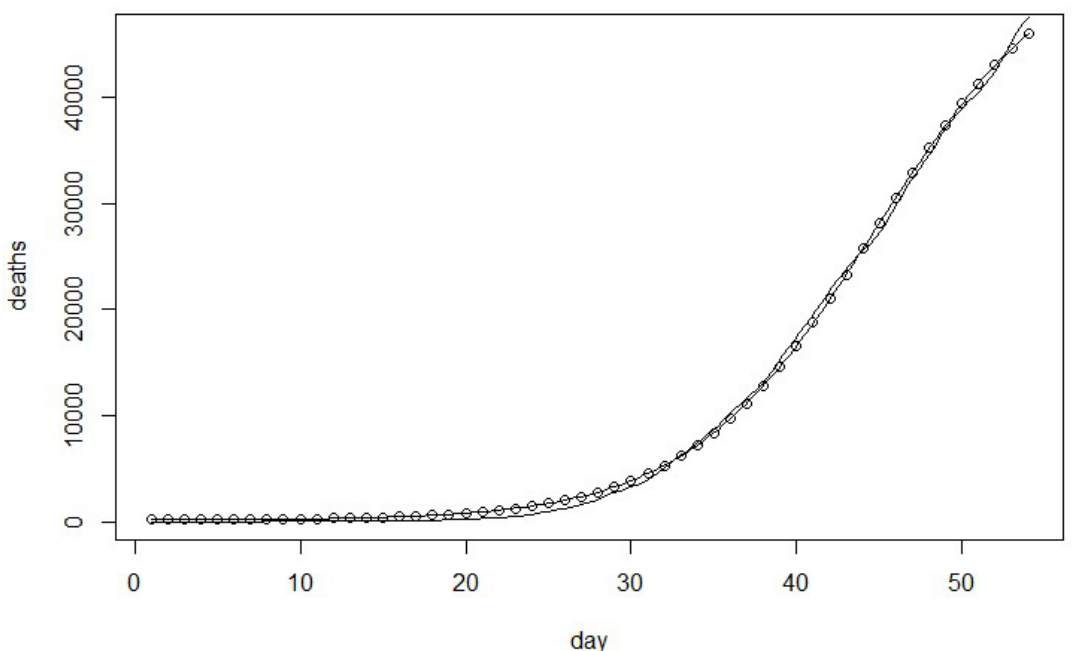
Figure 1. The estimated cumulative number of deaths vs. actual death data from Model 1.